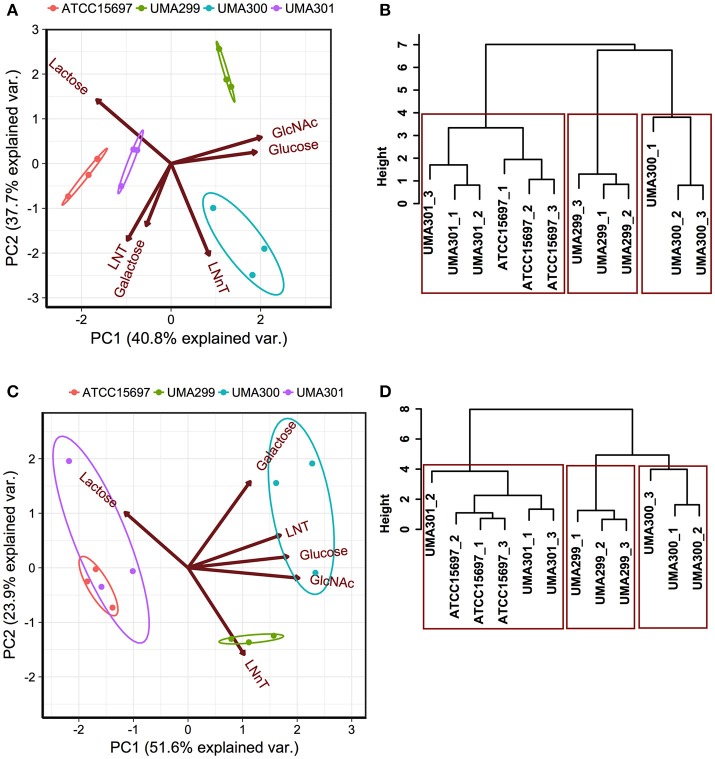
Strain dependent variation of human milk oligosaccharide utilization. Panels (A,C) depict the 2D-principal component analysis (PCA) performed on the final asymptotic OD600 and the growth rate (k, h−1) respectively. The arrows in PCA plot represent the correlation of variables with the principal components (PC1 and PC2). Points represent the scores of each component grouped as biological replicates. The ellipses encompassing each strain capture 68% of the normal probability of the scores within corresponding strains. Panels (B,D) show the hierarchical clustering dendrogram of strains on the final asymptotic OD600 nm and the growth rate (k, h−1) using ward method and Euclidean distance. The y-axis measures closeness of either individual strains or clusters. The boxes show the 95% of clustering and closeness of the strains.